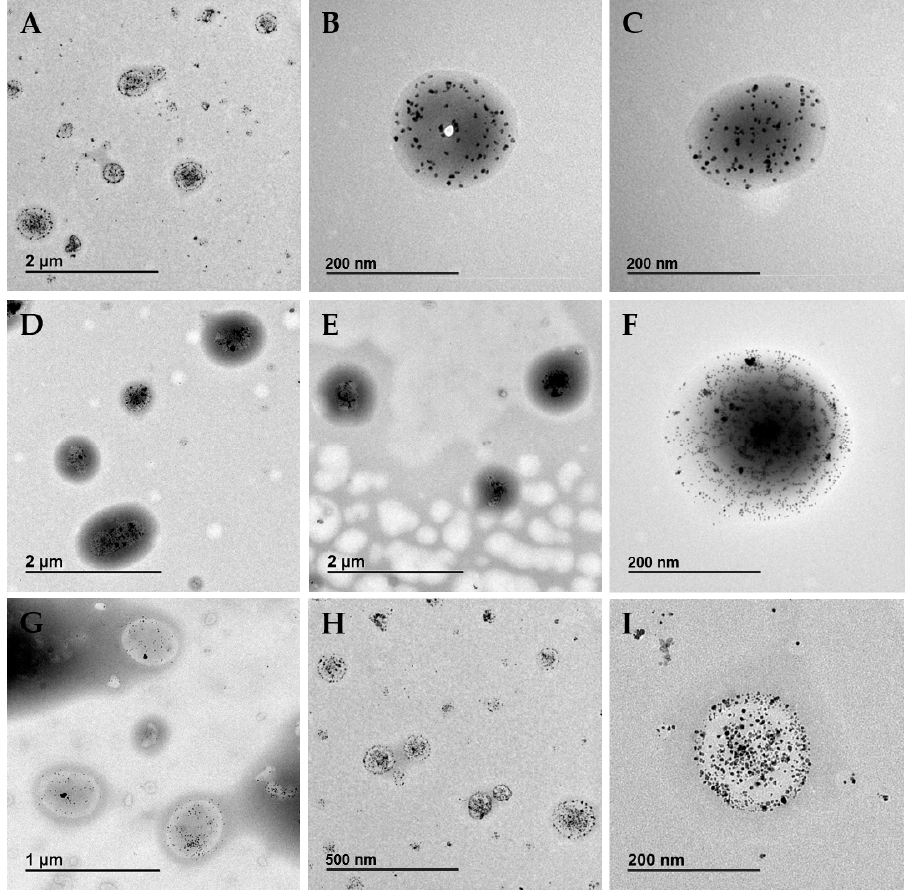
Figure 2. Representative TEM images for ( A – C ) PLGA@Ag 2 S_R1 NPs obtained by route 1. ( D – F ) PLGA@Ag 2 S_R2 NPs obtained by route 2, and ( G – I ) PLGA@Ag 2 S_R3 NPs obtained by route 3.